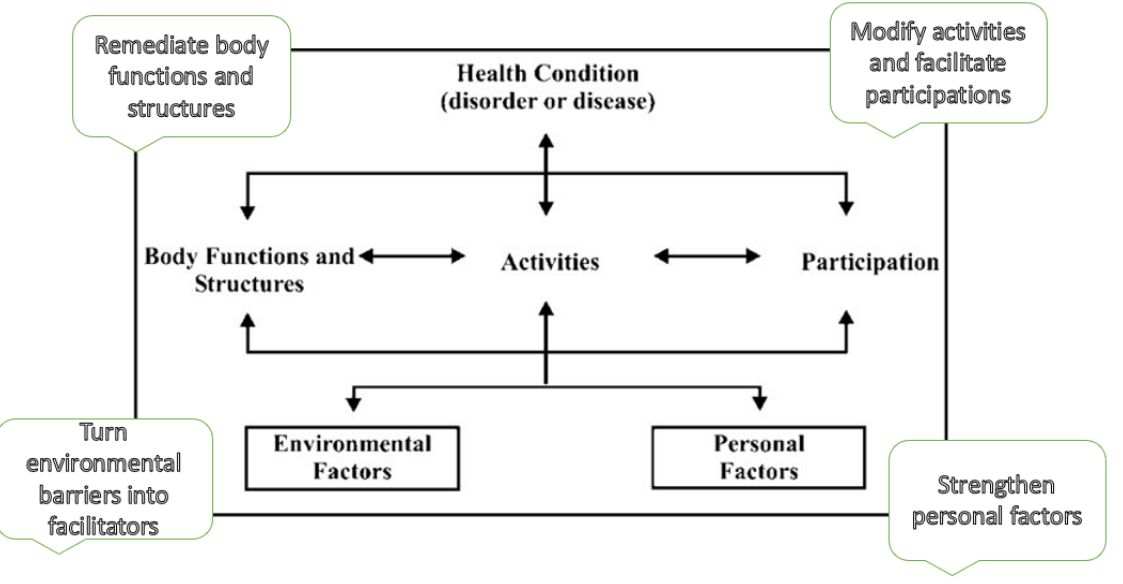
Figure 1. World Health Organization’s International Classification of Functioning, Disability and Health [1] and the role of health professionals. Note: the images were collected by Asistiva with full written permission for use.